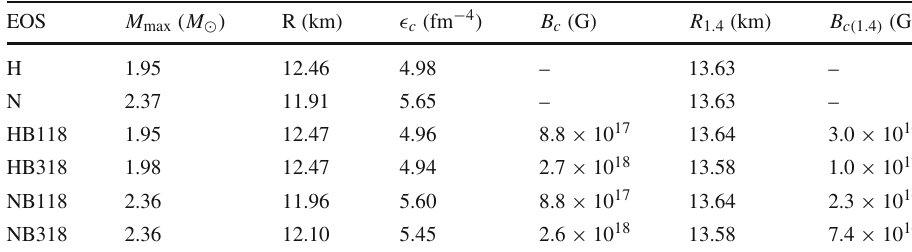
Table 2 Neutron stars main properties for each one of the six EOS. Indicating the maximum mass, the respective radius, central density, the radius of the canonical 1.4 M (cid:2) star and the central magnetic field for the maximum mass and the canonical one